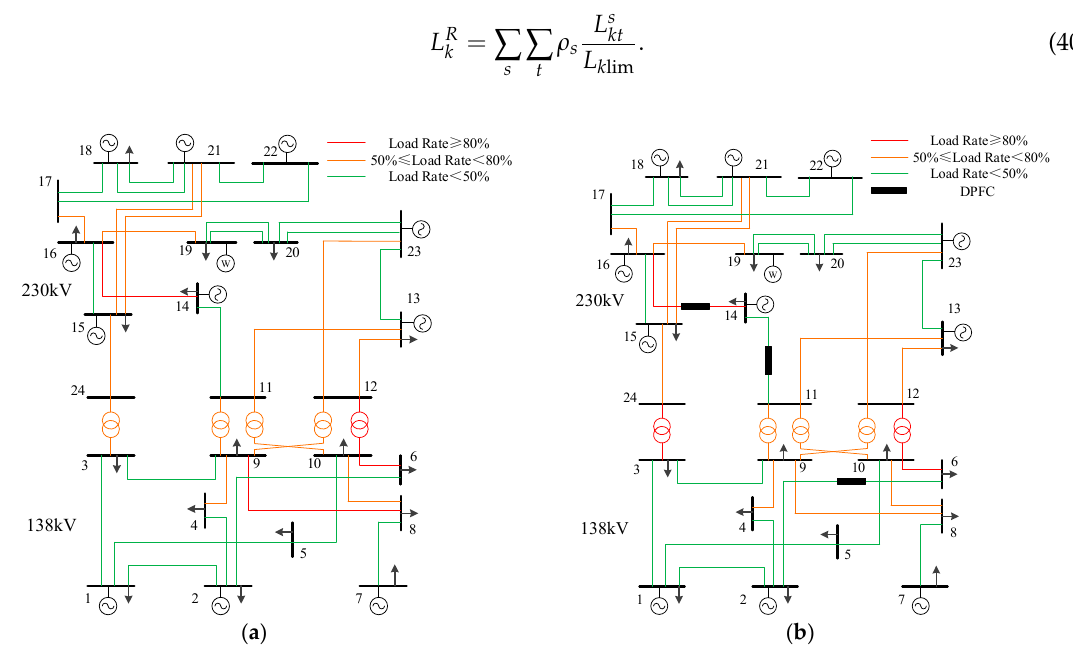
Figure 6. Power flows in IEEE-RTS79 system, ( a ) without DPFCs, and ( b ) with DPFCs. Table 2. Optimal configuration of DPFC.